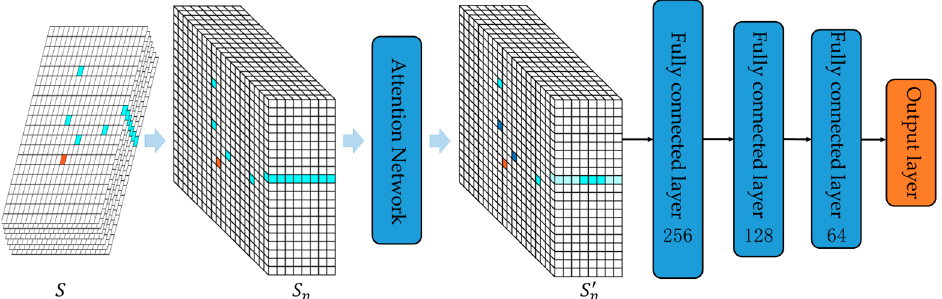
Figure 12. Structure of the attention network based on state information.